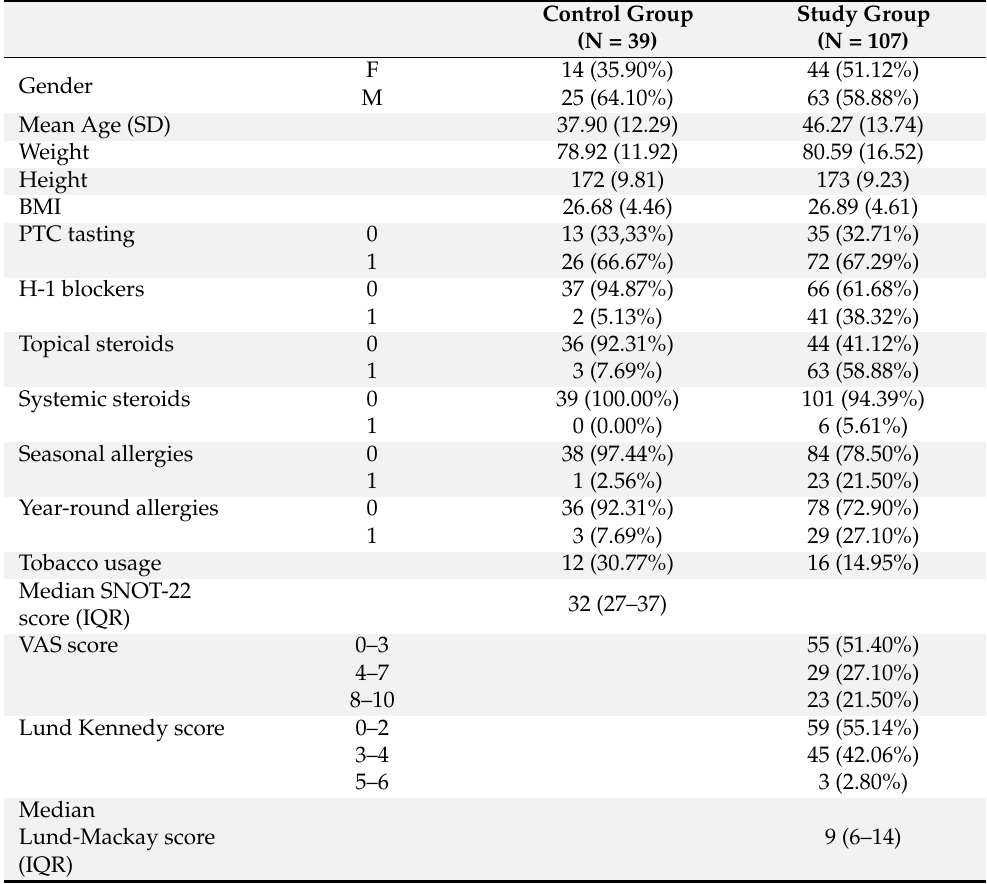
Table 1. Characteristics of the study (N = 107) and the control (N = 39) groups. F = female, M = male, BMI = body mass index, PTC = phenylthiocarbamide, SNOT-22 = Sino-nasal Outcome Test-22, VAS = visual analog scale, SD—standard deviation, IQR—interquartile